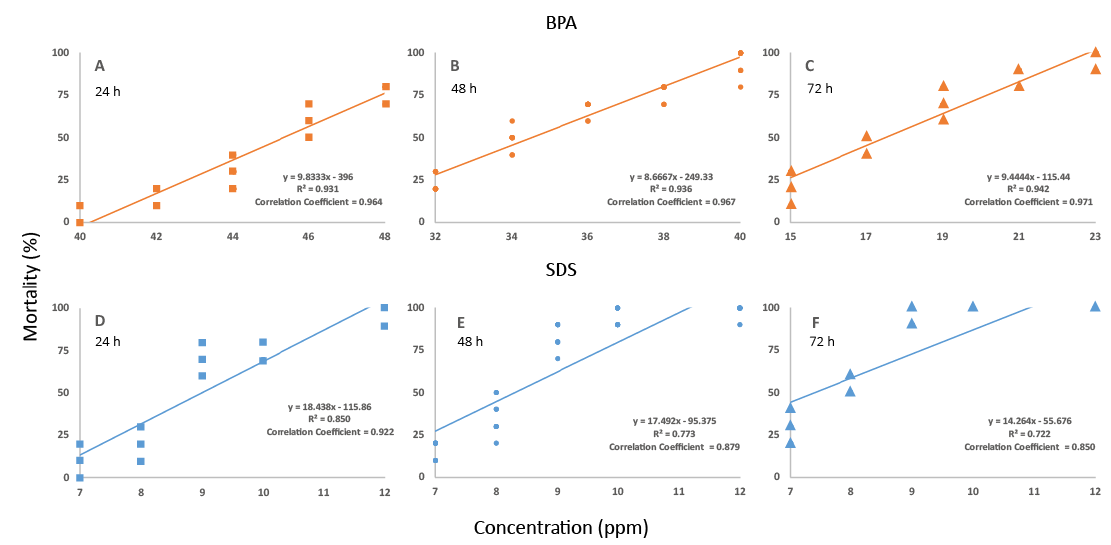
Figure 2. Concentration—Mortality curves and the estimated linear regression equations after exposure of Artemia franciscana nauplii to BPA for: ( A ) 24 h, ( B ) 48 h, ( C ) 72 h, and to SDS for: ( D ) 24 h, ( E ) 48 h, and ( F ) 72 h.